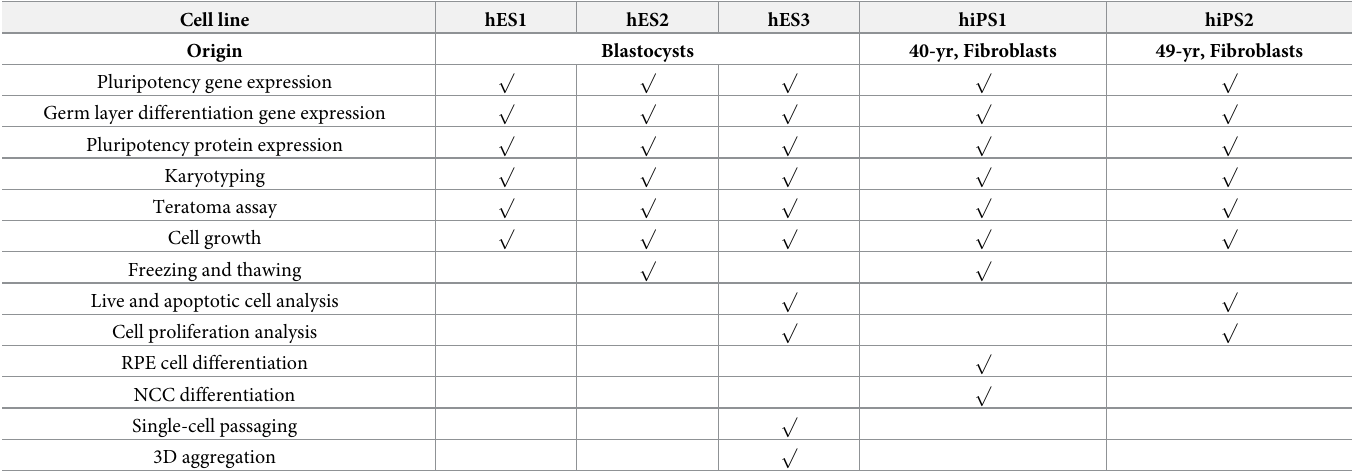
Table 1. List of hPSC lines used. Cell line hES1 hES2 hES3 hiPS1 hiPS2 Origin Blastocysts 40-yr, Fibroblasts 49-yr, Fibroblasts Pluripotency gene